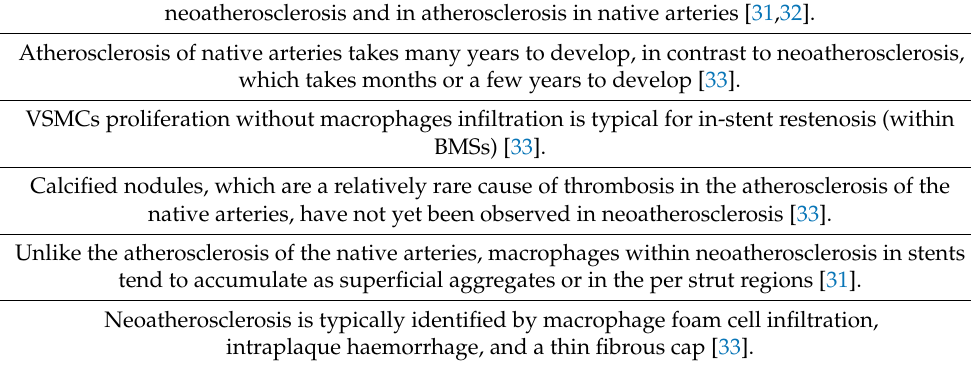
Table 1. Selected differences and similarities between neoatherosclerosis and atherosclerosis in native